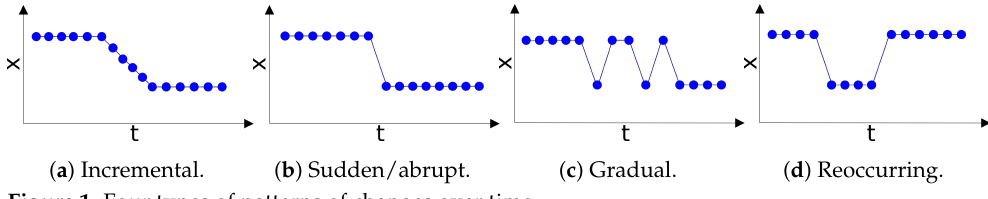
Figure 1. Four types of patterns of changes over